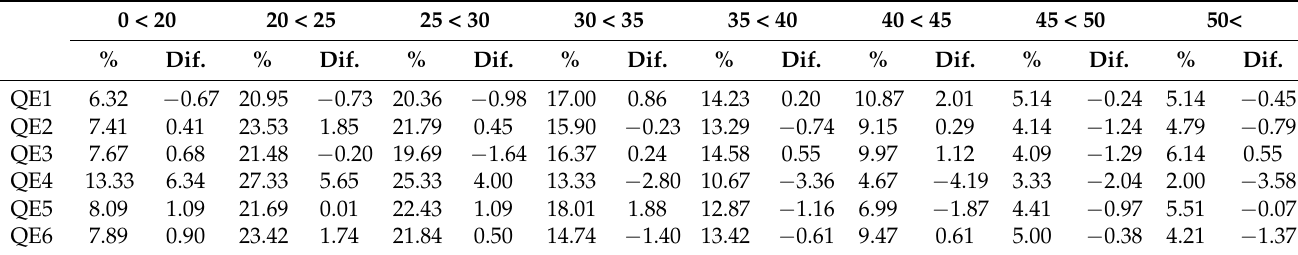
Table 12. Game elements distributed by